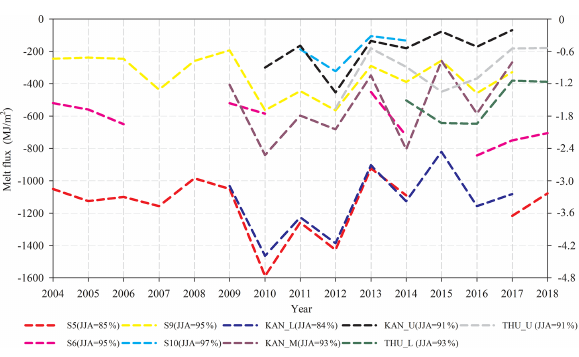
Figure 7. Annual melt energy (2004–2018) at the nine AWS sites and JJA melt energy percentage of the annual total. The dashed line is the annual melt energy (MJm − 2 ), and the right y axis represents the approximate melt water equivalent